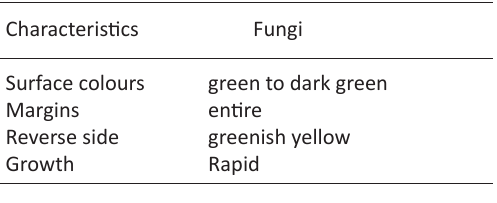
Fig. 1. Microscopic Observation of pesticide degrading Fungi Table 1. Morphological characteristics